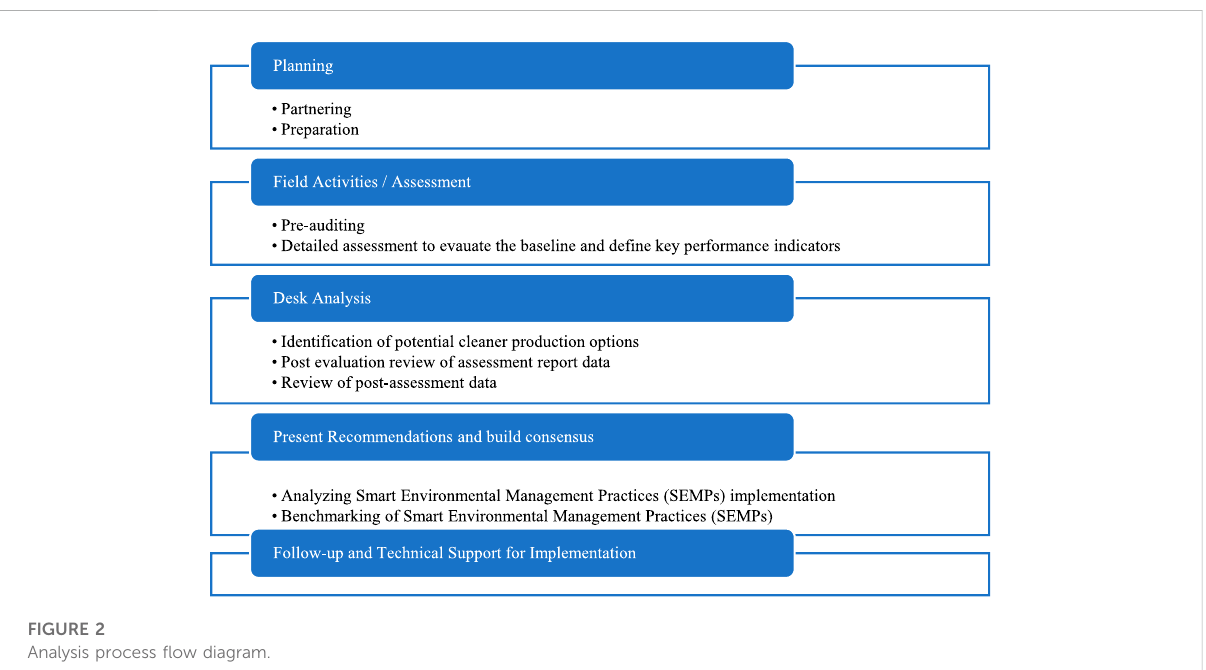
FIGURE 2 Analysis process fl ow